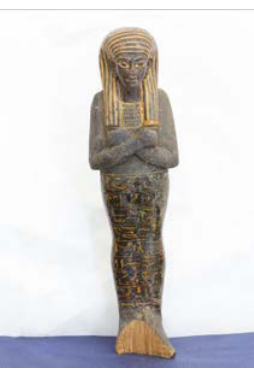
Figure 2. The wooden ushabty of the minister Imenmes with the written part depicted on the body of the mummy